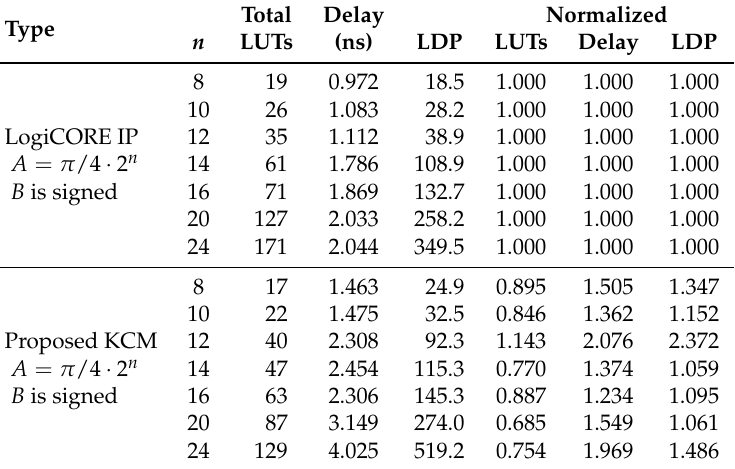
Table 3. Synthesis results for single-cycle ( m × n )-bit KCMs, where m = n , A = π /4 · 2 n and B is a signed variable. Proposed KCMs use 15% fewer LUTs on average compared to LogiCORE IP KCMs at the expense of increased delay.